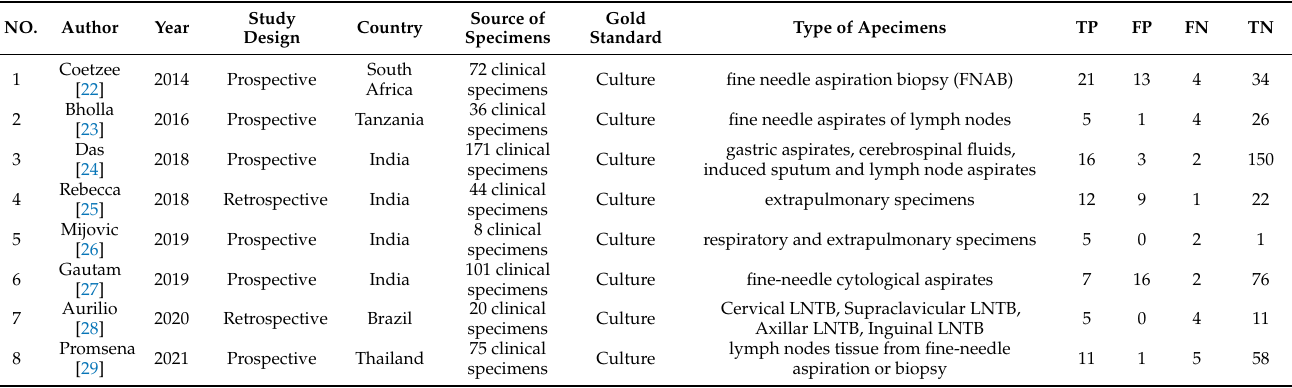
Table 1. Characteristics of the included studies ( n = 8).